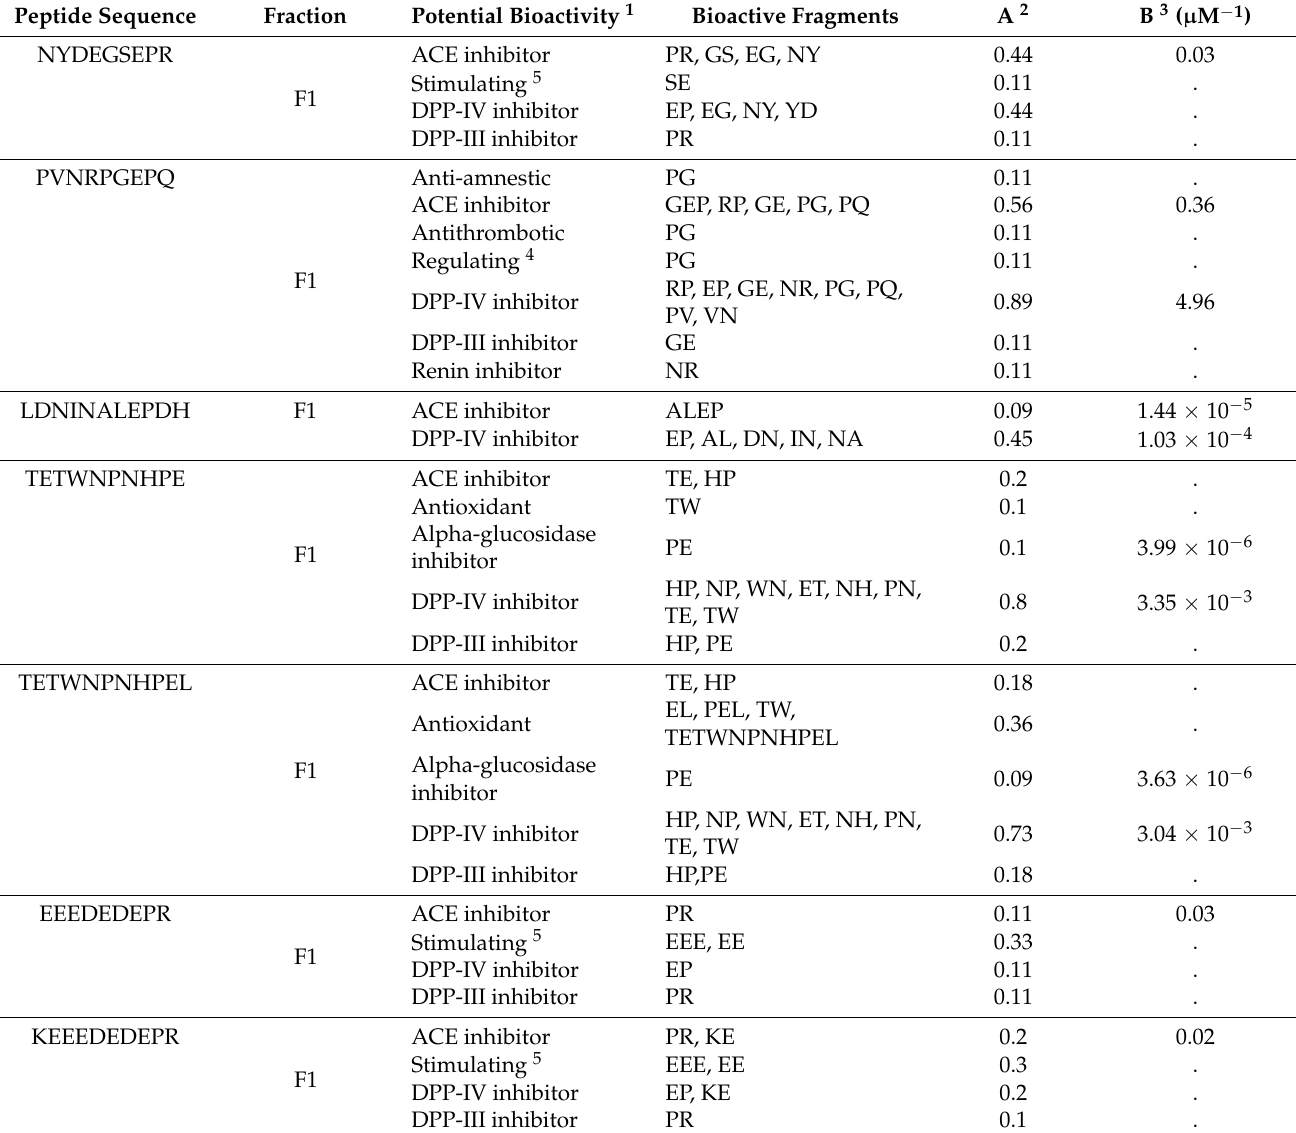
Table 5. In silico prediction of bioactive properties of the LC-MS/MS identified faba bean peptides using the BIOPEP-UWM